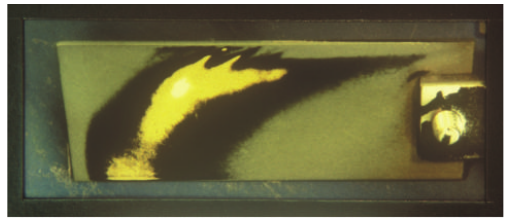
Figure 1: Backside of pitched blade impeller.